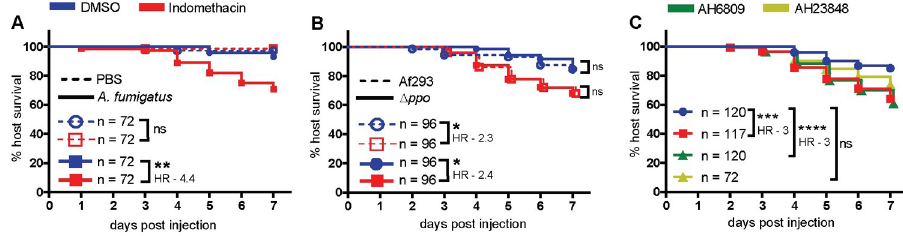
Fig 1. Host cyclooxygenase signaling promotes survival of A . fumigatus -infected larvae. (A) Survival of wild-type larvae injected at 2 dpf with TBK1.1 (Af293) A . fumigatus spores or PBS mock-infection in the presence of 10 μ M indomethacin or DMSO vehicle control. (B) Survival of larvae injected at 2 dpf with A . fumigatus Af293 or Af293 triple- ppo -mutant ( Δ ppo ) spores and exposed to 10 μ M indomethacin or DMSO vehicle control. (C) Survival of larvae injected at 2 dpf with TBK1.1 (Af293) spores and exposed to 10 μ M indomethacin, 5 μ M AH6809, 10 μ M AH23848, or DMSO vehicle control. Data are pooled from at least three independent replicates, at least 24 larvae per condition, per replicate and the total larval N per condition is indicated in each figure. Cox proportional hazard regression analysis was used to calculate P values and hazard ratios (HR). Average injection CFUs: (A) 50, (B) Af293 = 40 and Δ ppo = 58, (C)